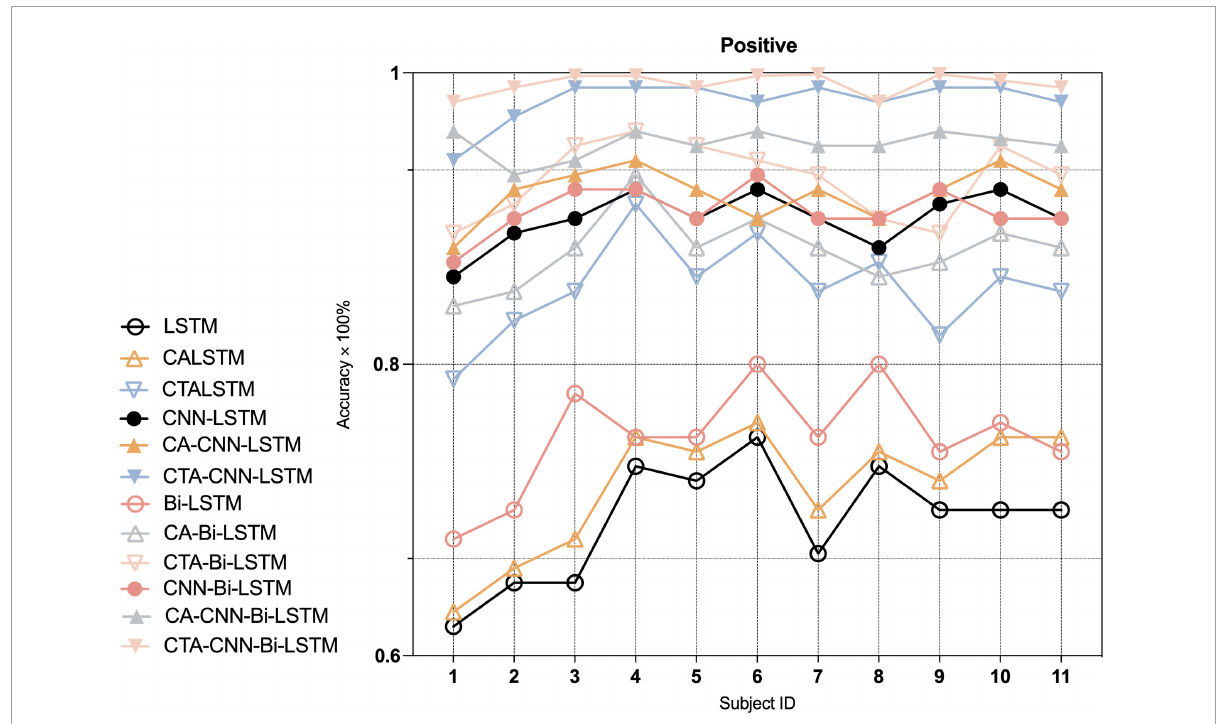
FIGURE9 Average accuracy (%) of baseline and proposed method on the recognition of positive emotion in each individual.